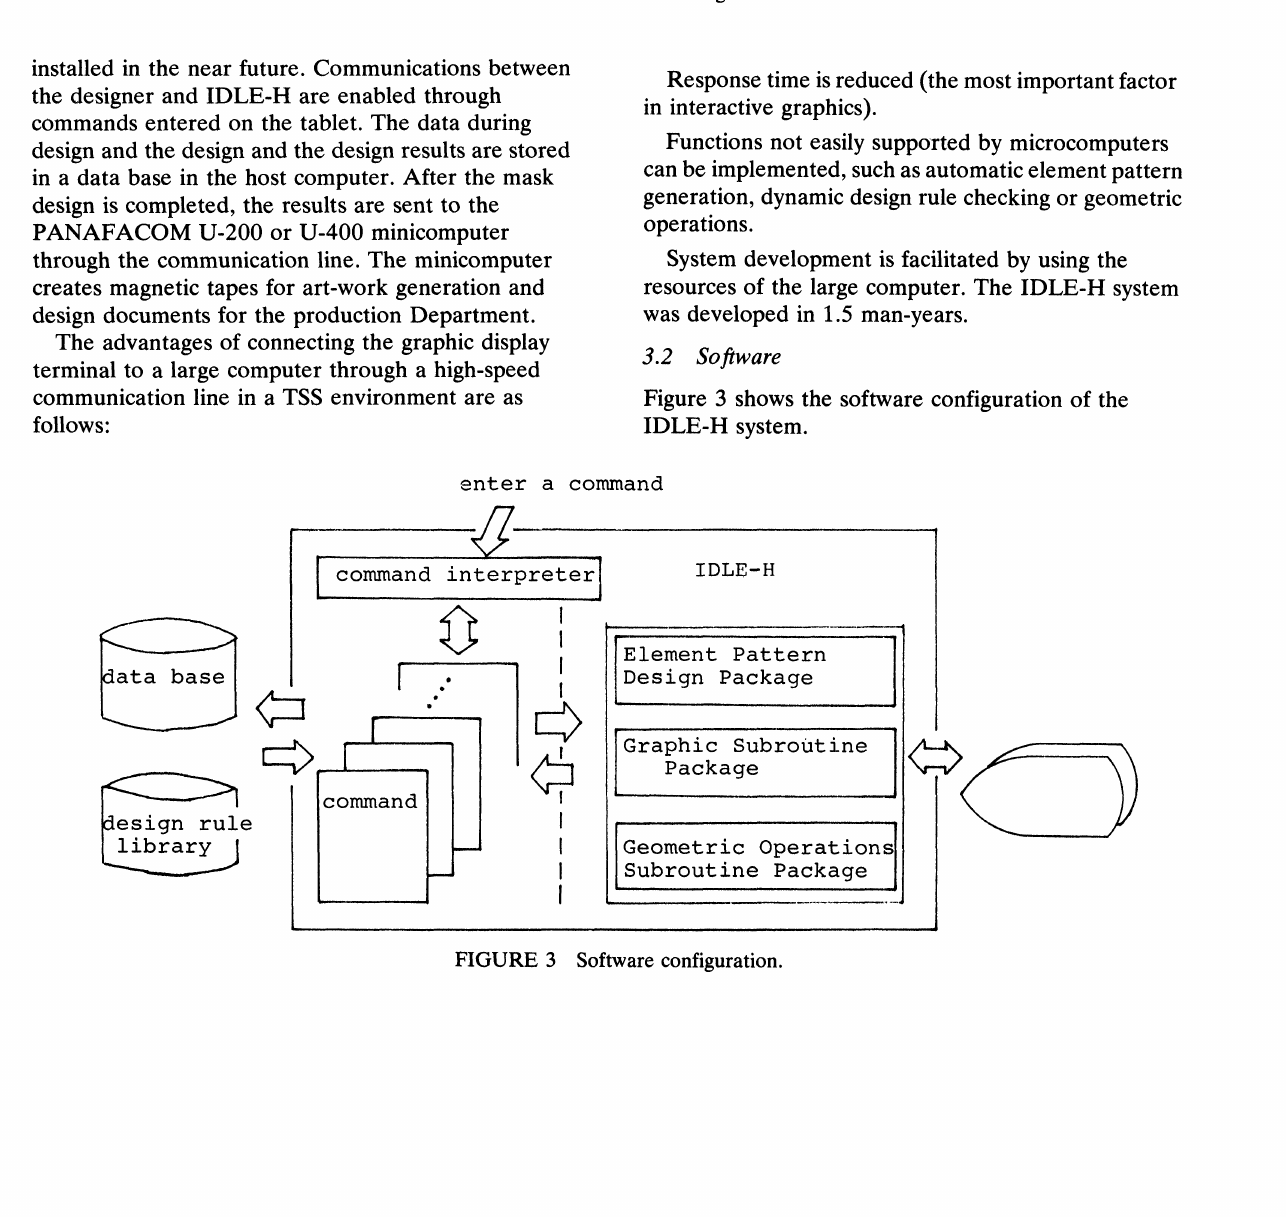
FIGURE 3 Software